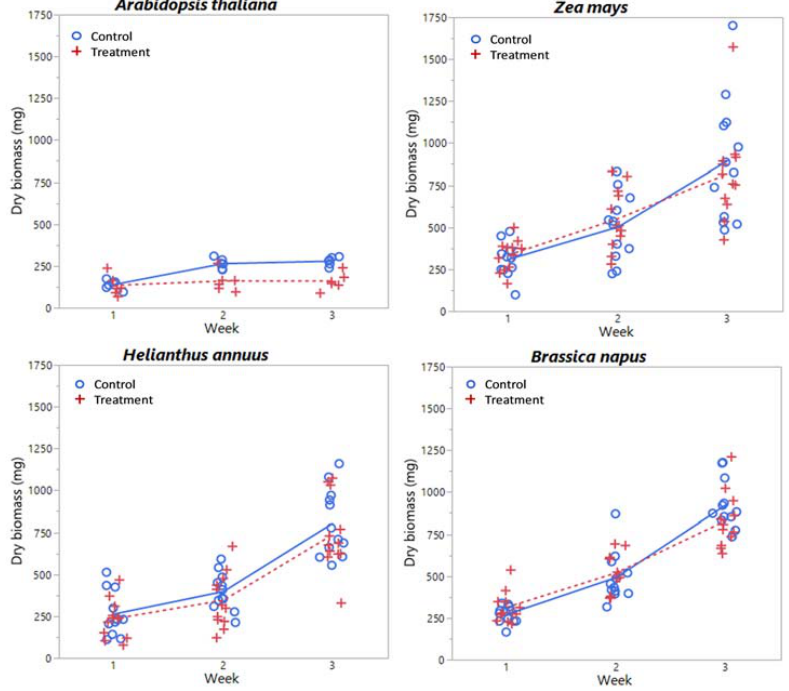
Figure 7. Dry biomass (mg) by week and treatment level for each species considered. Lines (solid = control, dashed = treatment) indicate mean values at each week.